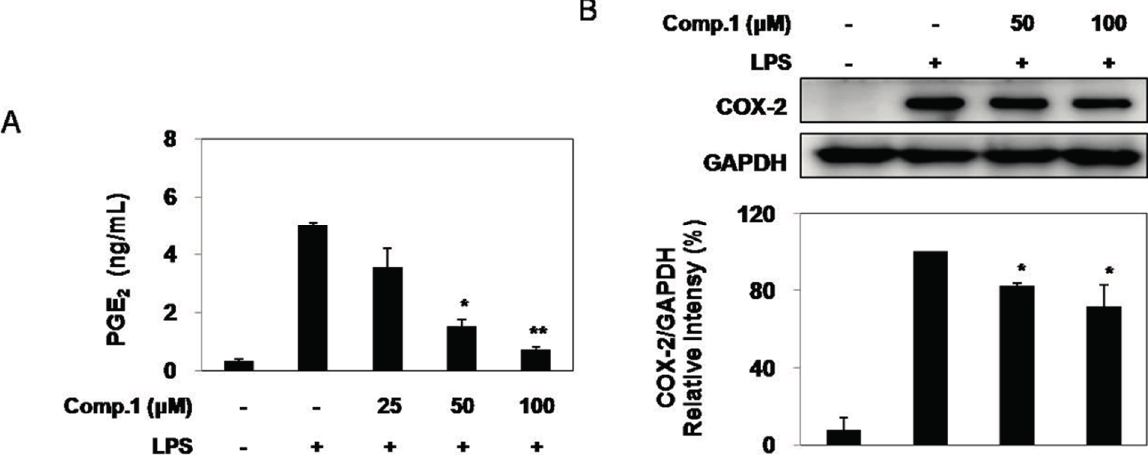
Figure 3. Effects of compound 1 on production of PGE 2 ( A ) and COX-2 expression ( B ) in LPS induced RAW 264.7 cells. RAW 264.7 cells were treated with different concentrations (25, 50, 100 μ M) of compound 1 for 1 h prior to stimulation with 100 ng/mL of LPS for 24 h. Control values were obtained in the absence of LPS or compound 1 . The values are the mean ± SD of three independent experiments (significant as compared to control. * p <